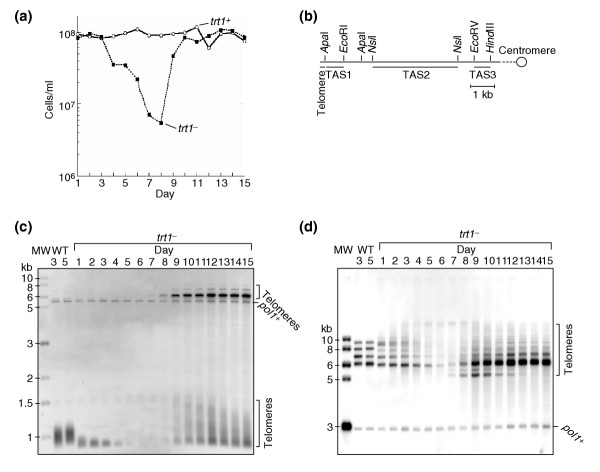
Senescence and emergence of survivors in trt1- cells. (a) Growth curves. YES cultures (200 ml) were inoculated at 2.5 × 104 cells/ml with either trt1+ or trt1- cells. Cell density is shown for trt1+ cells (open circles) and trt1- cells (filled squares) at the end of each 24-h period, after which a new culture was inoculated at 2.5 × 104 cells/ml. When cells were counted on day 1, they had already undergone about 45 generations after germination. Note that when the culture density reached 3-5 × 106 cells/ml, a portion of the cells was harvested for microarray analysis and Southern hybridization. Cells appeared enlarged near day 8 and were morphologically normal by day 11. (b) Restriction-enzyme sites in the TAS of one chromosome arm cloned into the plasmid pNSU70 [58]. Locations of the probes used for Southern hybridization are indicated by the bottom bars. These probes hybridize to multiple chromosome arms because the TASs are found on the four arms of chromosomes I and II and, depending upon the strain background, on one or both arms of chromosome III. (c) Telomere length in wild-type and trt1- strains from the growth curve. DNA (~15 μg) was digested with EcoRI, subjected to electrophoresis, transferred to a nylon membrane and probed with the 32P-labeled telomere fragment shown in (b) that was expected to report the state of the telomere end. As a loading control, a probe for the single-copy gene pol1+ was included. Signals arising from the telomeres are labeled. (d) As in (c), but DNA was digested with HindIII and the blot probed with TAS2 and a fragment of pol1+. The TAS2 probe was expected to hybridize to sequences at least 2 kb, and up to 6 kb, from the telomere end.